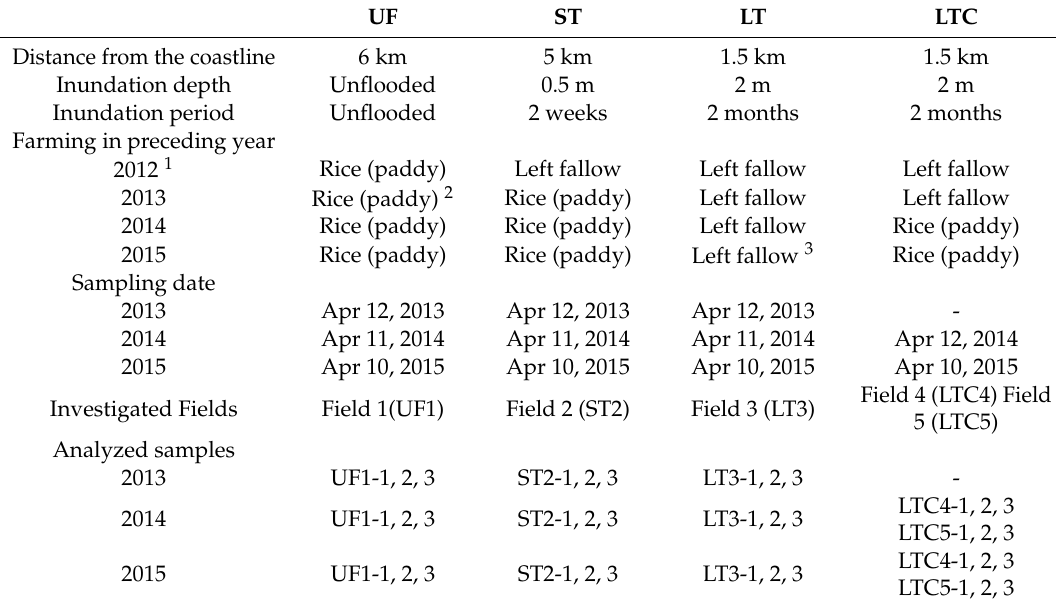
Figure 1. Location of the sampling sites. Samples were taken from unflooded fields (UFs), fields flooded for two weeks (short term, ST), fields flooded for two months (long term, LT), long-term flooded + cultivated fields (LTC), bay sediment (BYS), sea sand (SS), and seawater (SW) in the areas nearest the epicenter. Table 1. Degree of tsunami inundation and agricultural usage of sampling places.